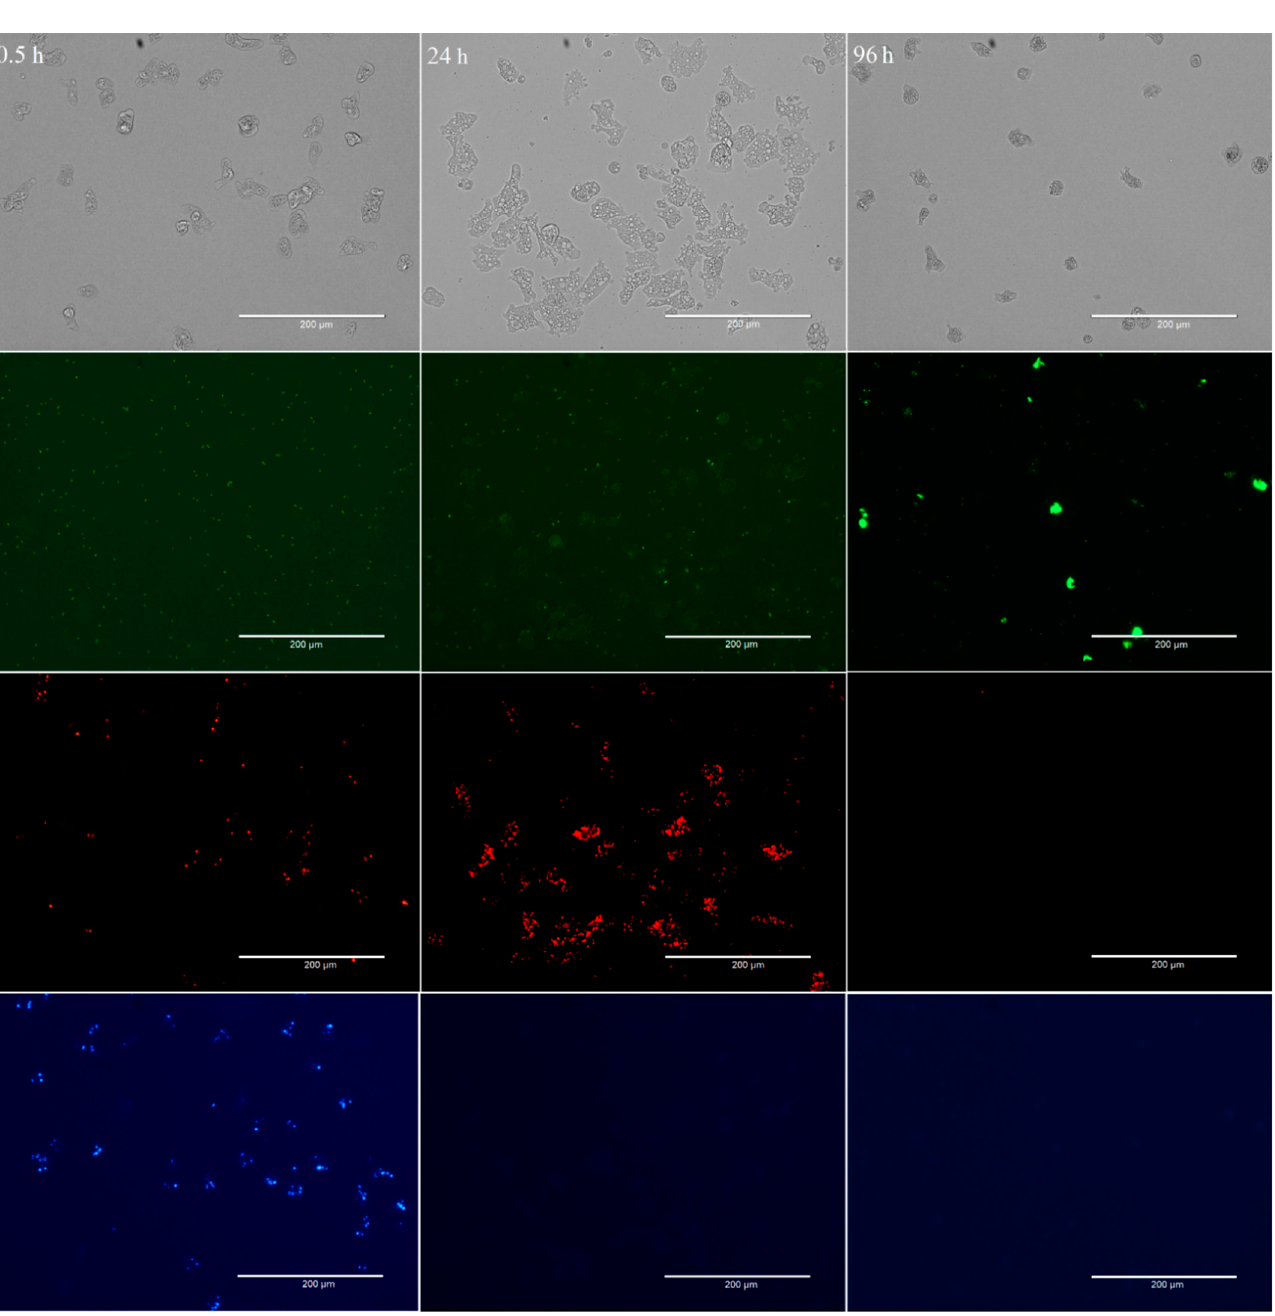
Figure 1. Preferential feeding on bacteria by W. magna at RT at different time points (0.5, 24, and 96 h) of co-culture. The four images (from top to bottom) represent the same field of view under different fluorescent light channels, Monocolor transmission light channel, Green fluorescent channel to observe GFP- L. pneumophila , Texas-Red channel for mCherry- E. coli MG1655, and DAPI channel for BFP- E. coli TOP10. The clusters of color dots in images indicate the presence of different intracellular bacteria in the food vacuoles of W. magna trophozoites. The scattered color dots (smaller in size) indicate planktonic bacterial cells in the medium.